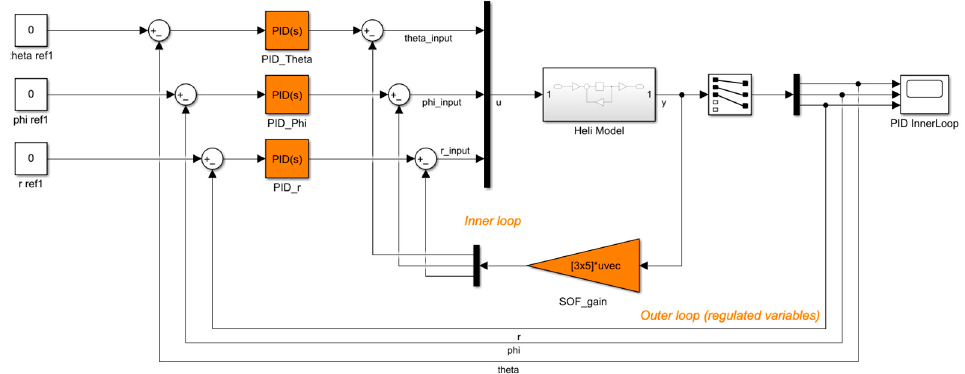
Figure 5. Multiloop PID with Static Output Feedback Control Block Diagram [24].